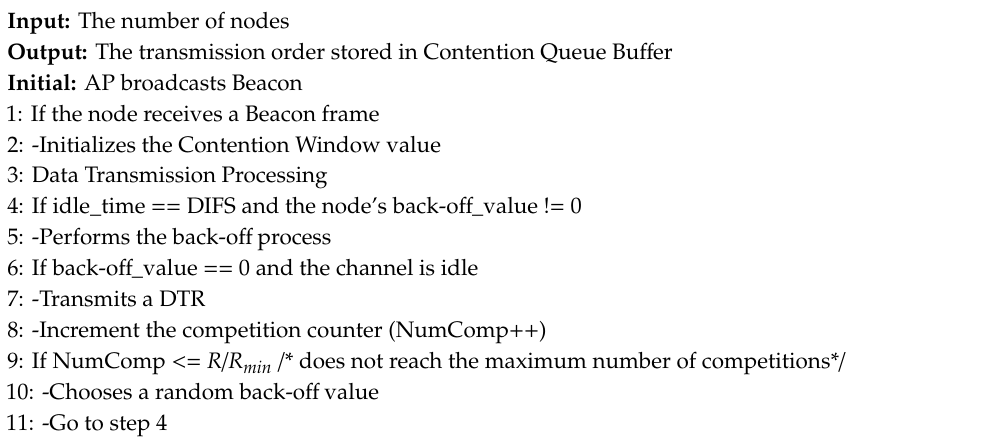
Algorithm 1 Contention Processing for I-DMAC1